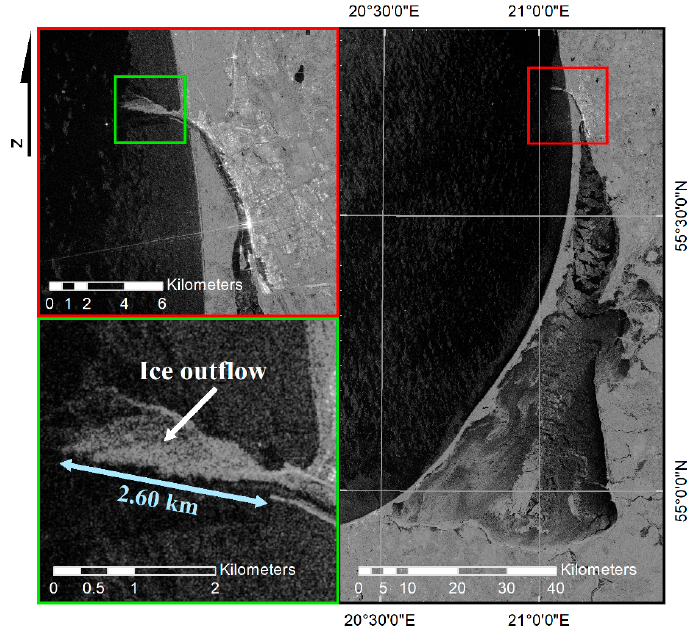
Figure 3. Sentinel-1B image of ice outflow from the Curonian Lagoon to the Baltic Sea (taken on the January 6 2017). The light blue arrow indicates the magnitude of the ice outflow from the port gates.